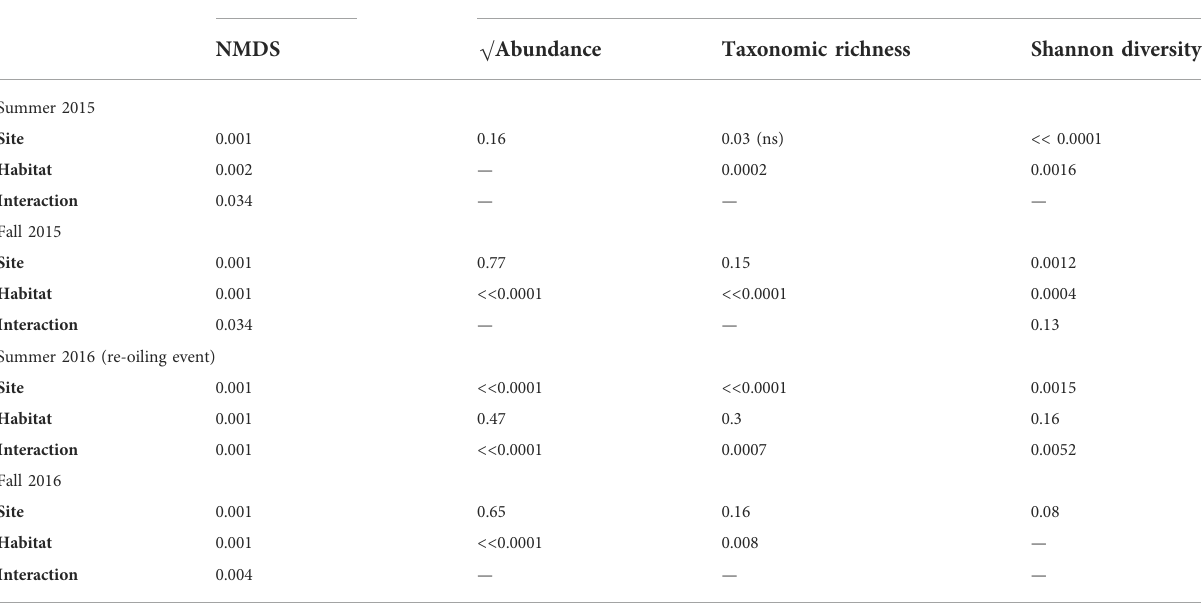
TABLE 3 Summary of p -values for community-level analyses. PERMANOVA results from PERMANOVA apply to the NMDS analysis shown in Figure 2. ANOVAresultsaccompanyFigure3.FullstatisticaltablesareinSupplementaryAppendixS2.Whena p < 0.05ismarked(ns),thisindicatesthatthe p -value should not be considered signi fi cant after applying the Benjamini – Hochberg procedure (Supplementary Table